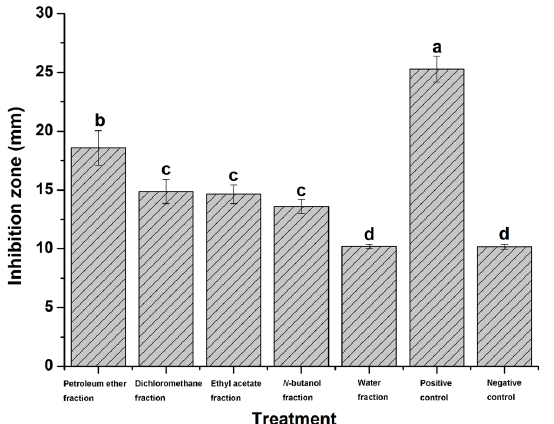
Fig. 1: Antimicrobial activity of five fractions from Athyrium sinense against Clavibacter michiganensis subsp. sepedonicus (Cms). Dif- ferent letters indicated significant difference ( P <0.05), and each inhibitory test was performed three times. DMSO dissolved in dis- tilled water to a concentration of 20% (v/v) was used as the control. The diameter of hole was 10 mm, and 20% DMSO had no notable antimicrobial activity against Clavibacter michiganensis subsp. sepedonicus (Cms). The data were expressed as mean ± standard deviation of three technical replicates (three inhibition tests using the same